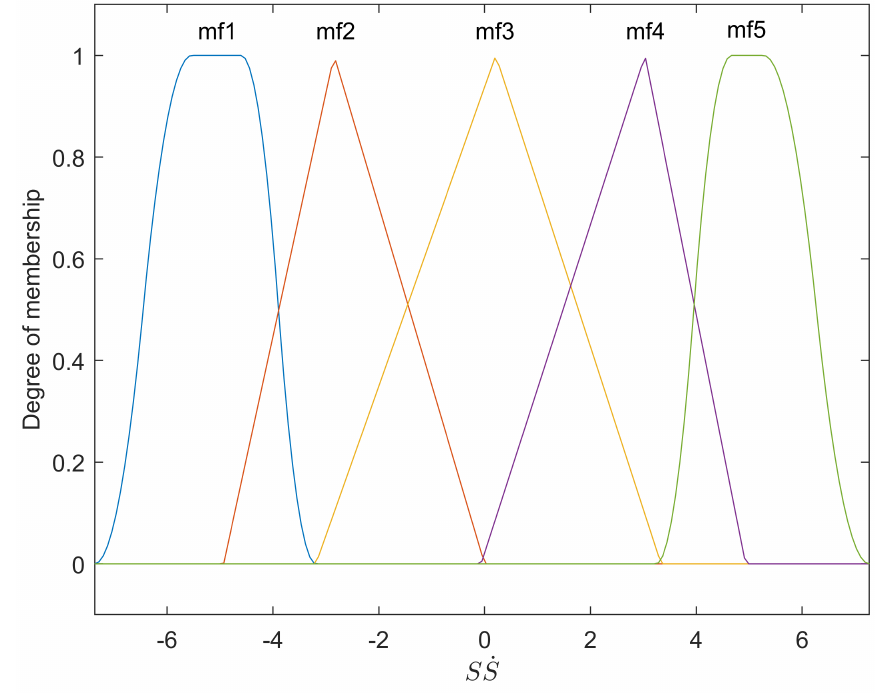
Figure 3. Membership function of S ˙ S .